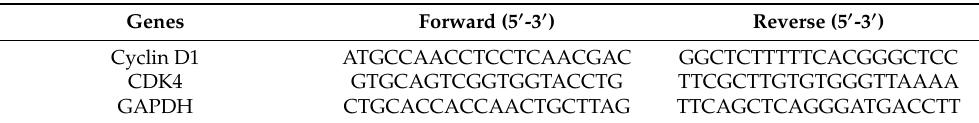
Table 2. Sequences for real-time RT-PCR